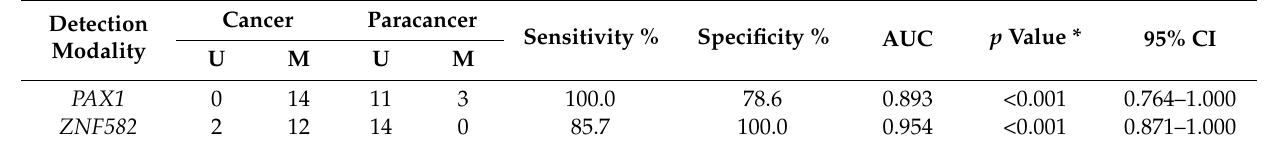
Table 2. Sensitivities, specificities, and AUC of PAX1 and ZNF582 methylation in detecting ESCC tumors ( n = 14). Detection